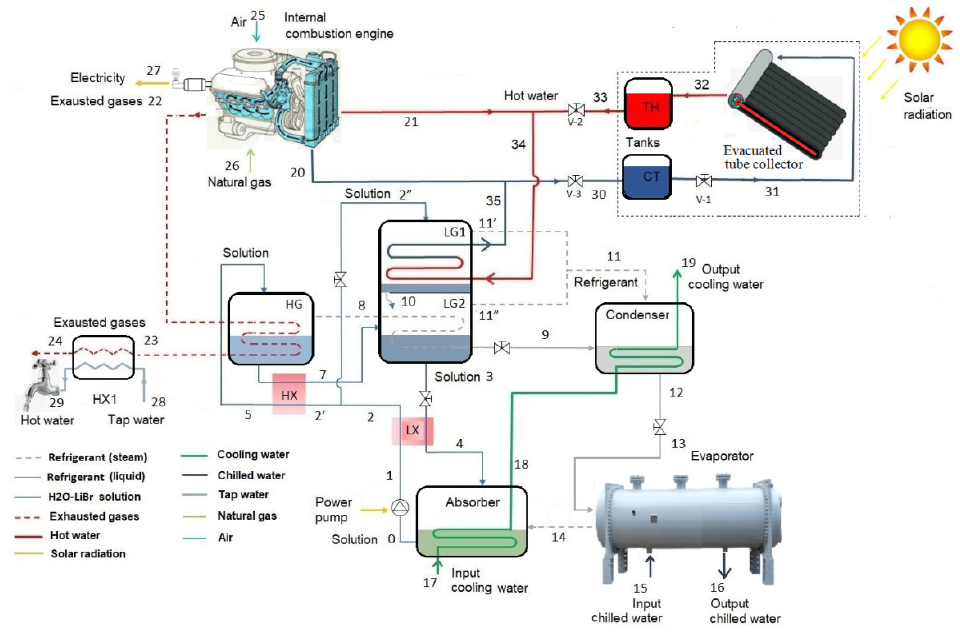
Figure 1. Scheme of the solar-assisted trigeneration system.